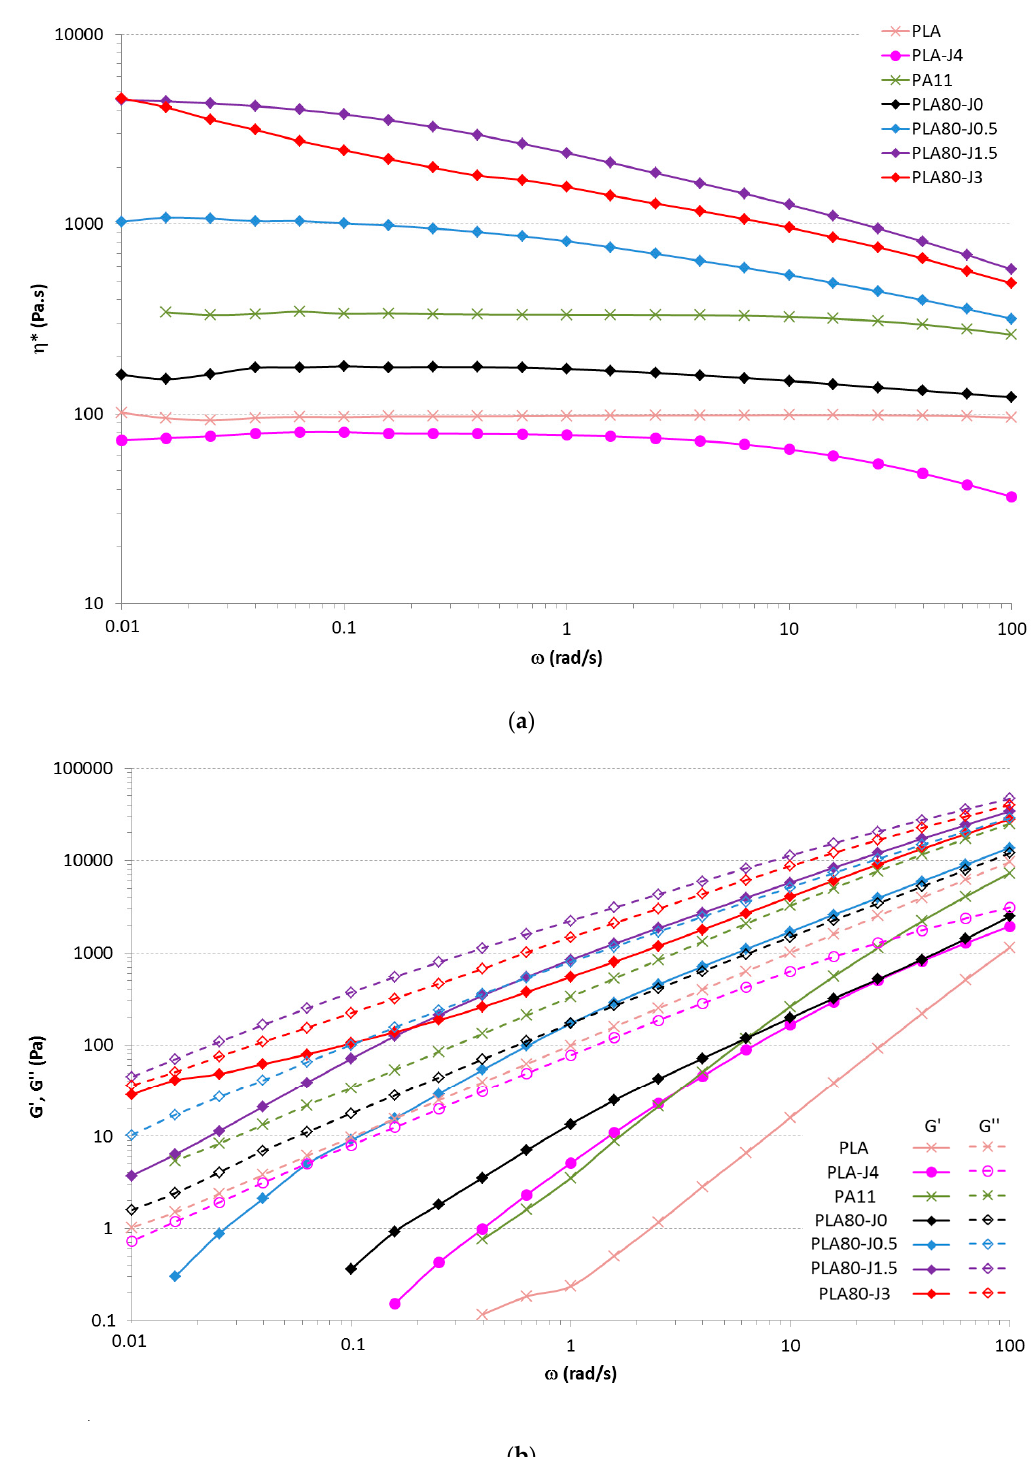
Figure 5. Complex viscosity ( a ), storage modulus (full lines) and loss modulus (dashed lines) ( b ) versus the angular frequency for PLA, PLA-J4 and PA11 PLA80-Jx blends (x = 0; 0.5; 1.5; 3). The complex viscosity curve of the neat PLA/PA11 blend is located between the values obtained for the neat polymers. When PLA-J4 is added, complex viscosity is increased with increasing Joncryl content in the blend over the whole frequency range. This result is in accordance with Walha et al.